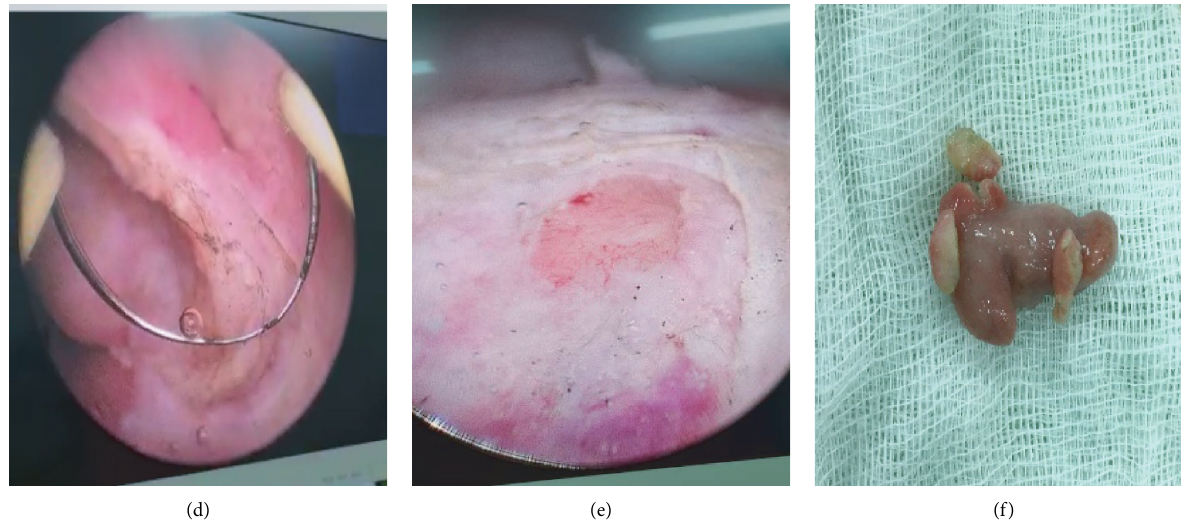
Figure 2: Polyp granulomatous sitting around the left ureteral meatus. (a) Granulomatous polyp developed on left ureteral meatus. (b) Left ureteral meatus. (c) Granulomatous polyp and its implantation base. (d) Resection of the granulomatous polyp. (e) Aspect of the left ureteral meatus after resection. (f) Resected granulomatous polyp.